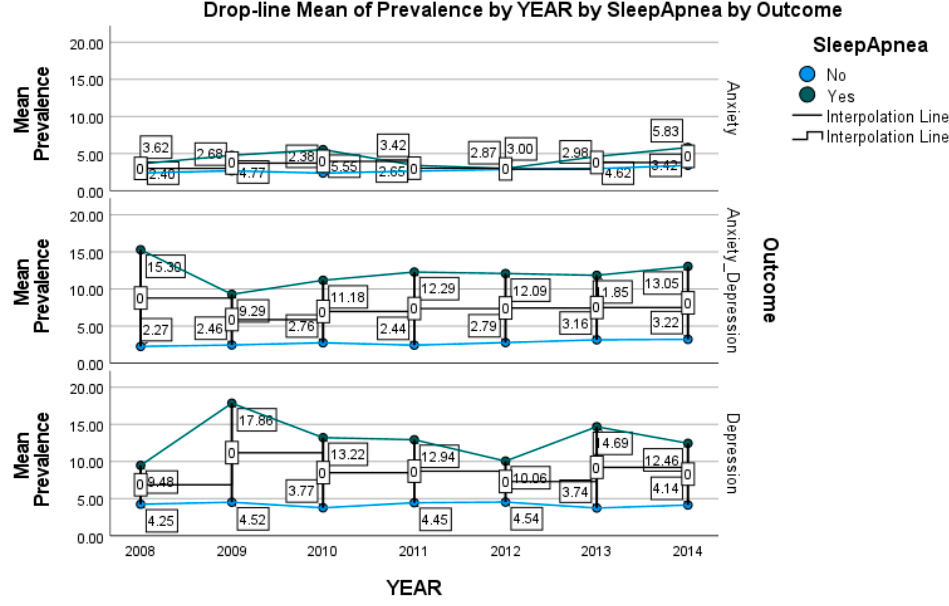
Figure 1. Prevalence of anxiety only, depression only, and their co-occurrence by year and sleep apnea.